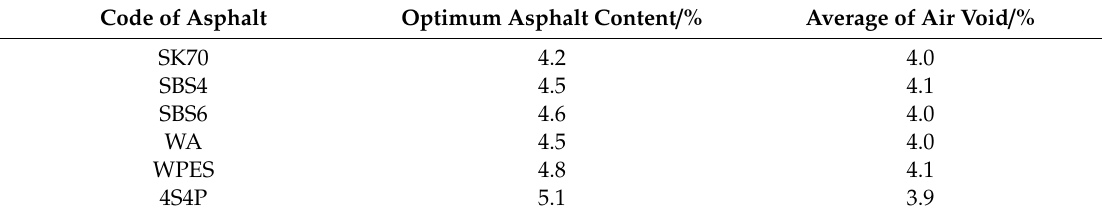
Table 4. Asphalt design